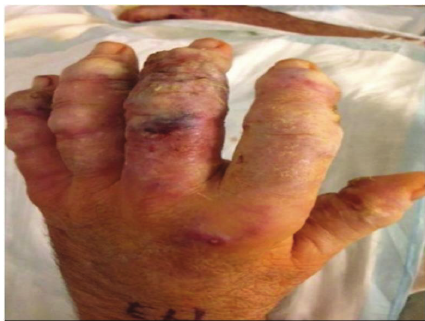
Figure 1: Inflammatory nodules on the left hand on second admission.